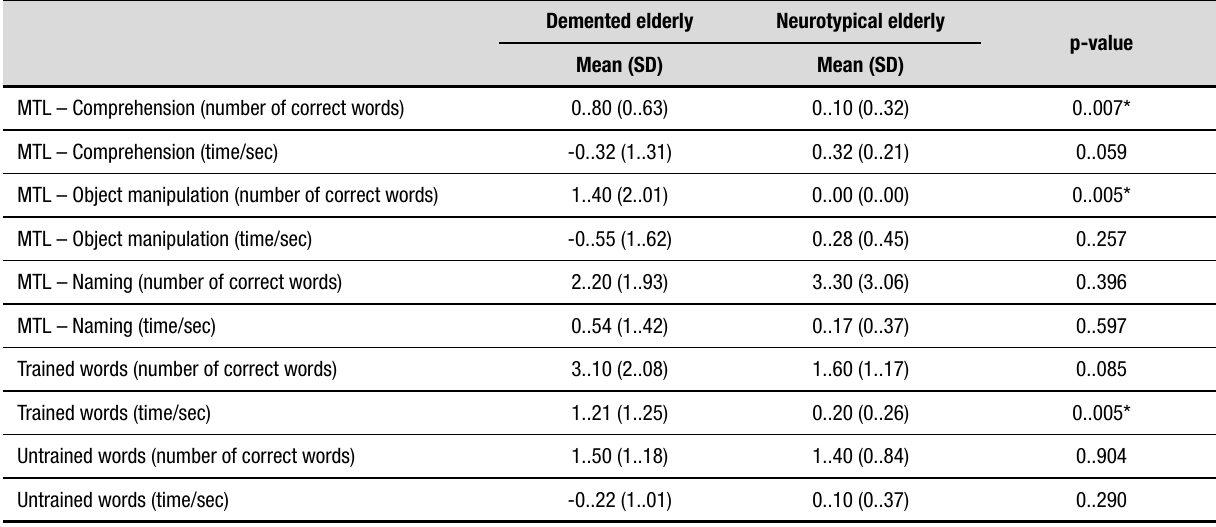
Table 3. Comparison of demented and neurotypical elderly for language performance after training.